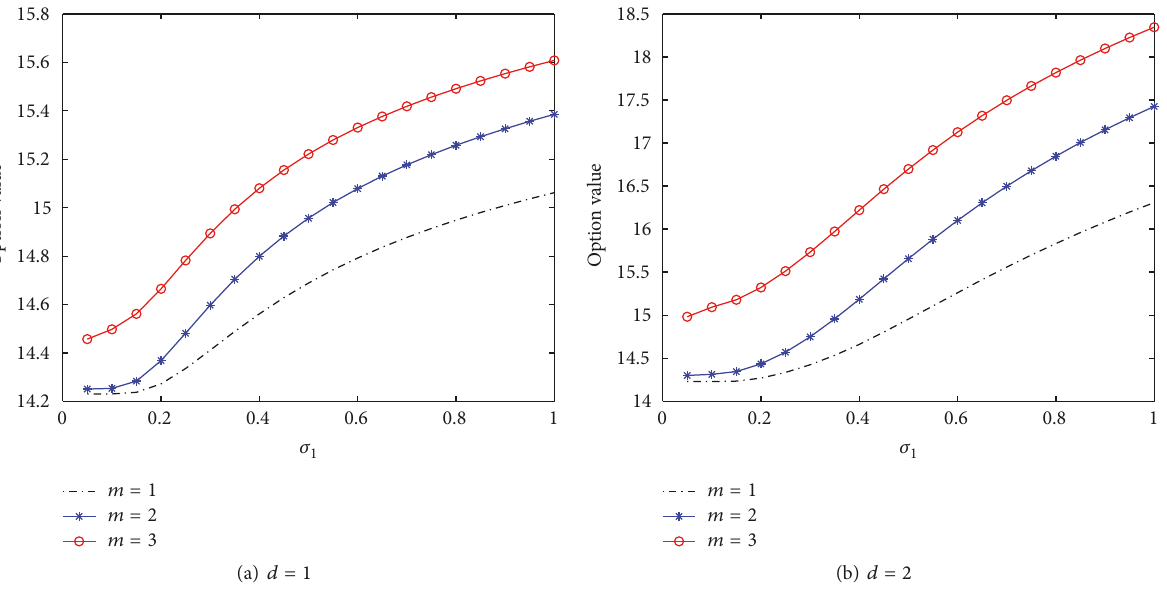
Figure 2: Option values as a function of volatility 𝜎 1